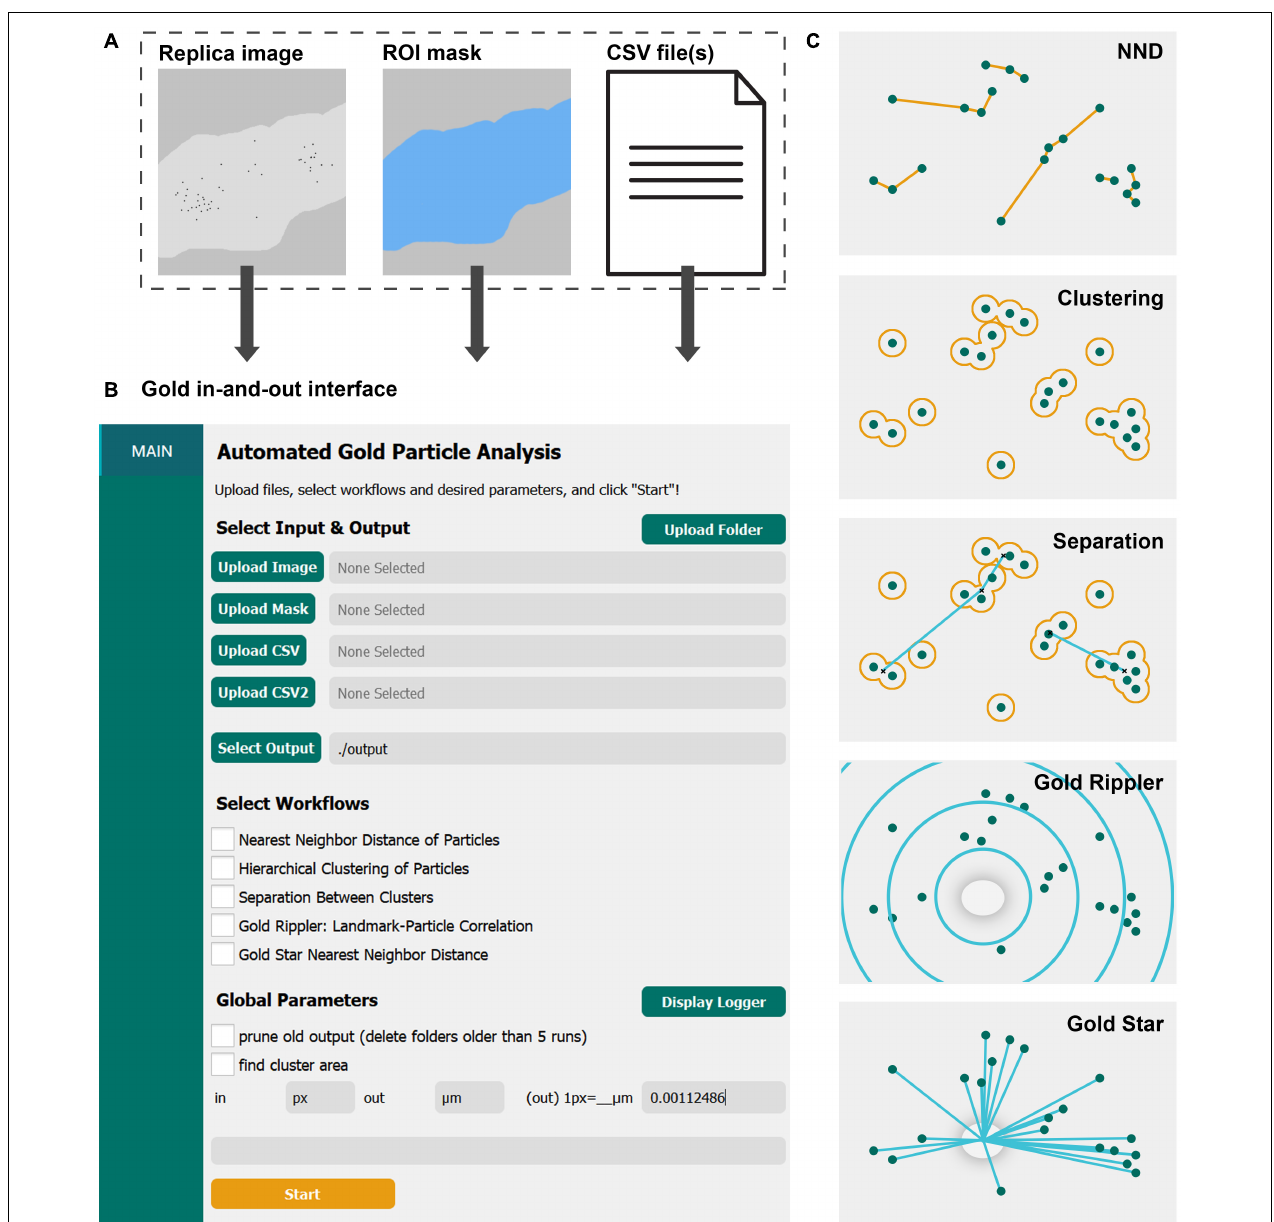
FIGURE 1 | GIO is a user-friendly graphical interface that provides several workflows for quantitative spatial analysis of immunogold particles on freeze-fracture replica images. (A) GIO takes three inputs—a montaged image of an immunogold labeled replica, an ROI mask of the membrane of interest, and CSV files of the XY coordinates of up to two populations of gold particles or structural landmarks. (B) The main interface of GIO, showing the folder upload button, individual file upload fields, the output folder field, workflow selections, and global parameters. (C) An illustration of the different workflows available in GIO. NND allows for measurement of nearest particle distances. Clustering groups particles based on their proximity to one another using a circle of a set radius. Separation measures the NND of cluster centroids (clusters shown as having two or more particles). Gold Rippler bins particles within concentric circles, or ripples, based on proximity to a landmark feature to measure particle bias toward or away from it. Gold Star measures nearest distances of particles to a landmark feature. The cross-fracture of a dendritic spine (gray oval) is shown as the landmark feature for both Gold Rippler and Gold Star.